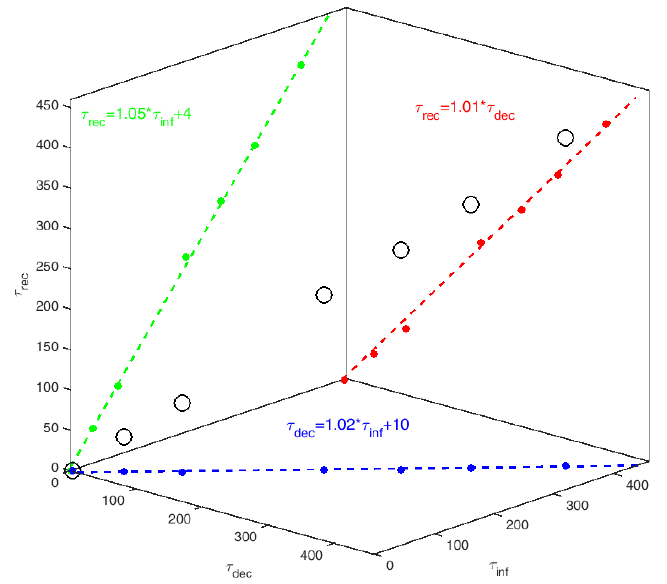
Figure 4. Tridimensional representation of the correlation between the timing of the events corre- sponding to the centroids of the Gaussian mixture used to fit infected, deceased and recovered people. Dashed lines correspond to linear fits between the corresponding